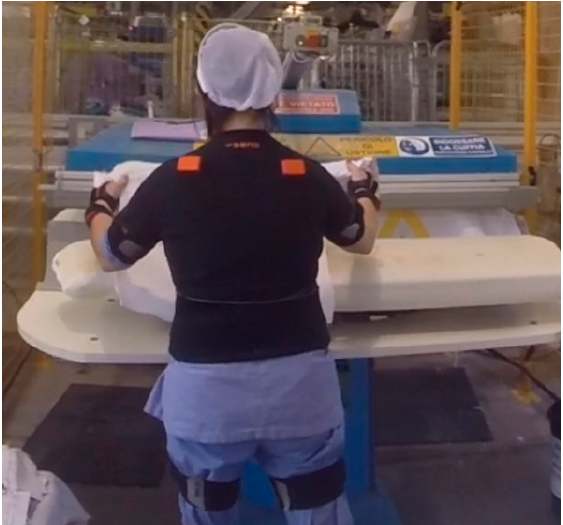
Figure 1. Placement of inertial sensors on a worker. Sensors are the orange probes, when visible, or inside the black